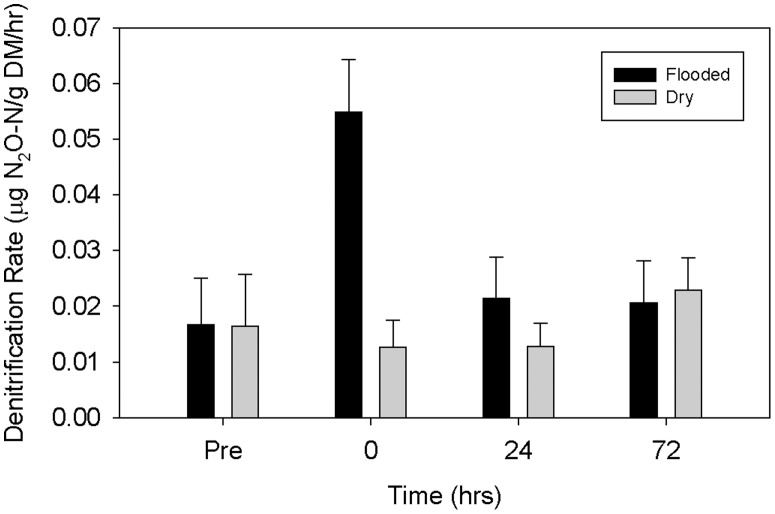
Mean denitrification rate by treatment over time.No significant differences were detected. Error bars indicate +1 SE.